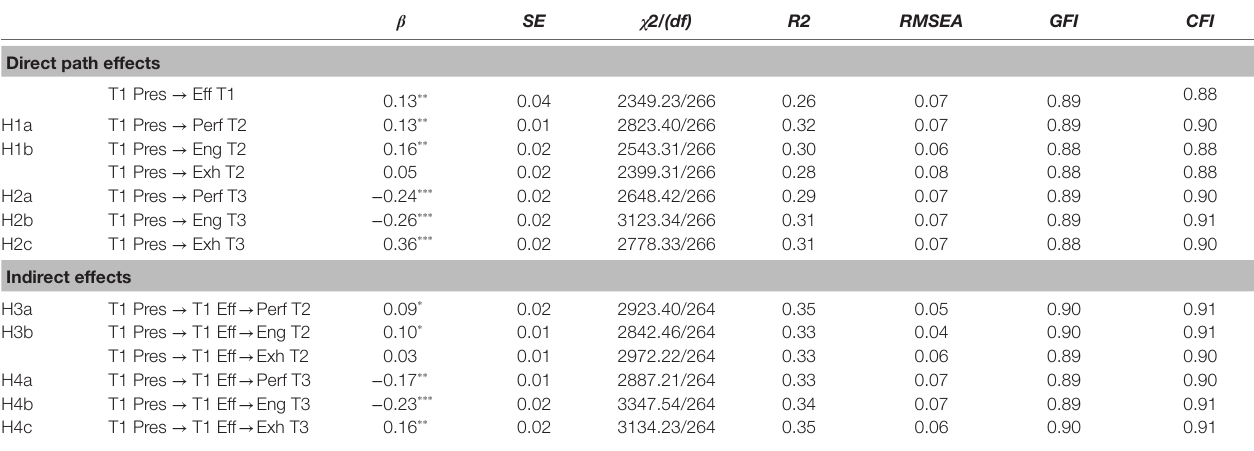
TABLE 2 | Medwiation effects of effort exertion between presenteeism behaviors and outcomes over a 1-month interval (T2) and a 12-month interval (T3). β SE χ 2/(df) R2 RMSEA GFI